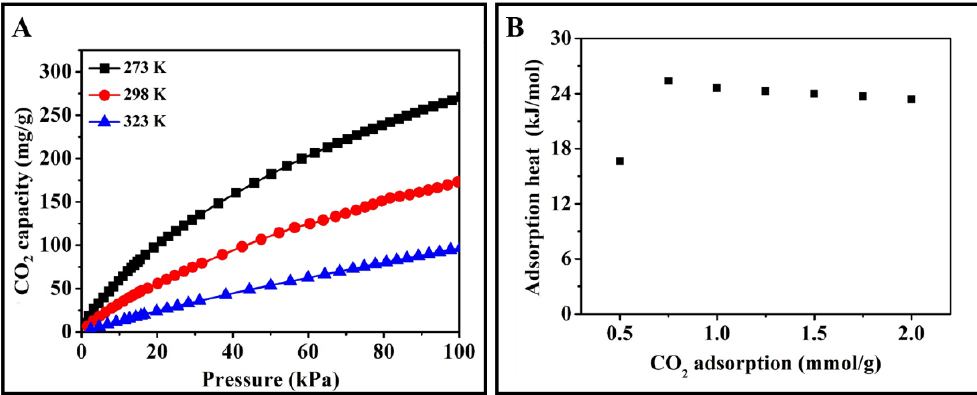
Figure 11. CO 2 adsorption isothermals ( A ) and CO 2 adsorption heats ( B ) of ACRF-40C-85%-800.